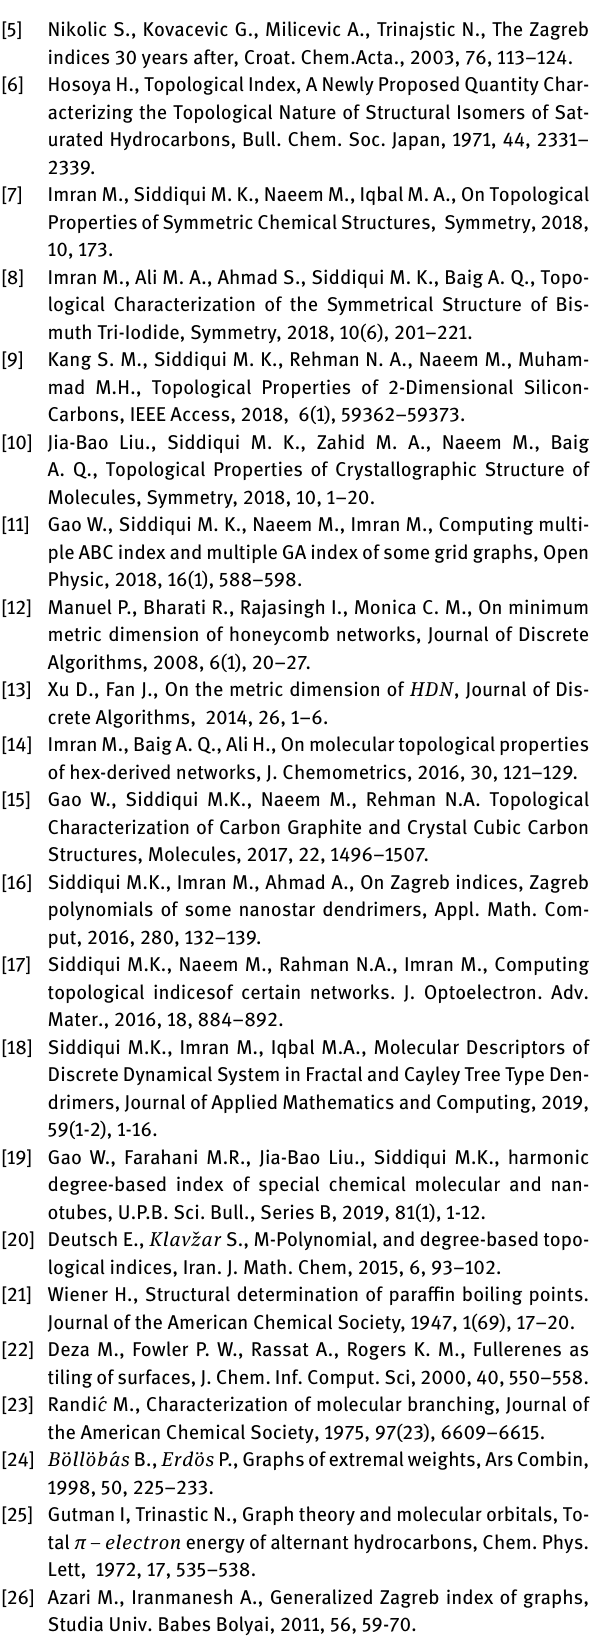
Figure 8: The comparison of all topological indices for HDN 2( n ) .